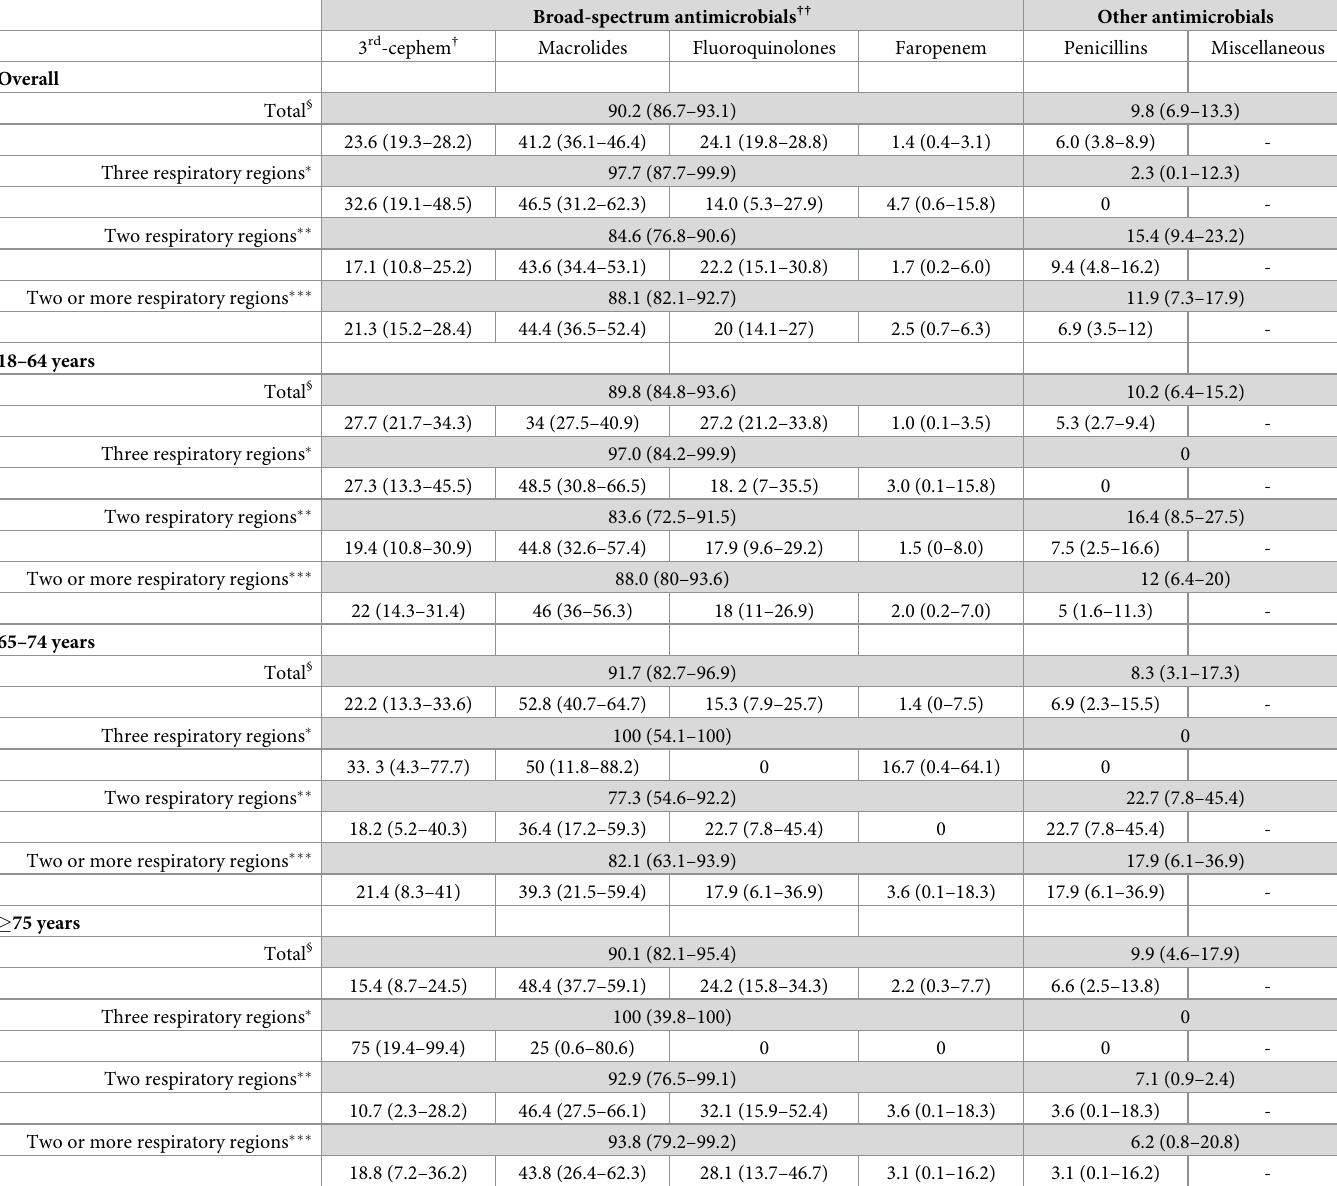
Table 3. Proportions of antimicrobials prescribed for common cold according to age groups and clinical